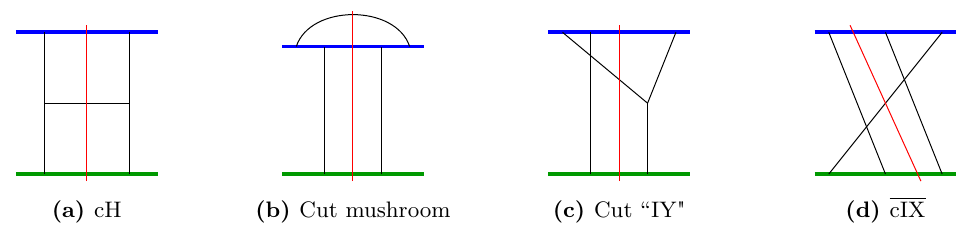
Figure 7. Cut topologies arising in the calculation of eq.